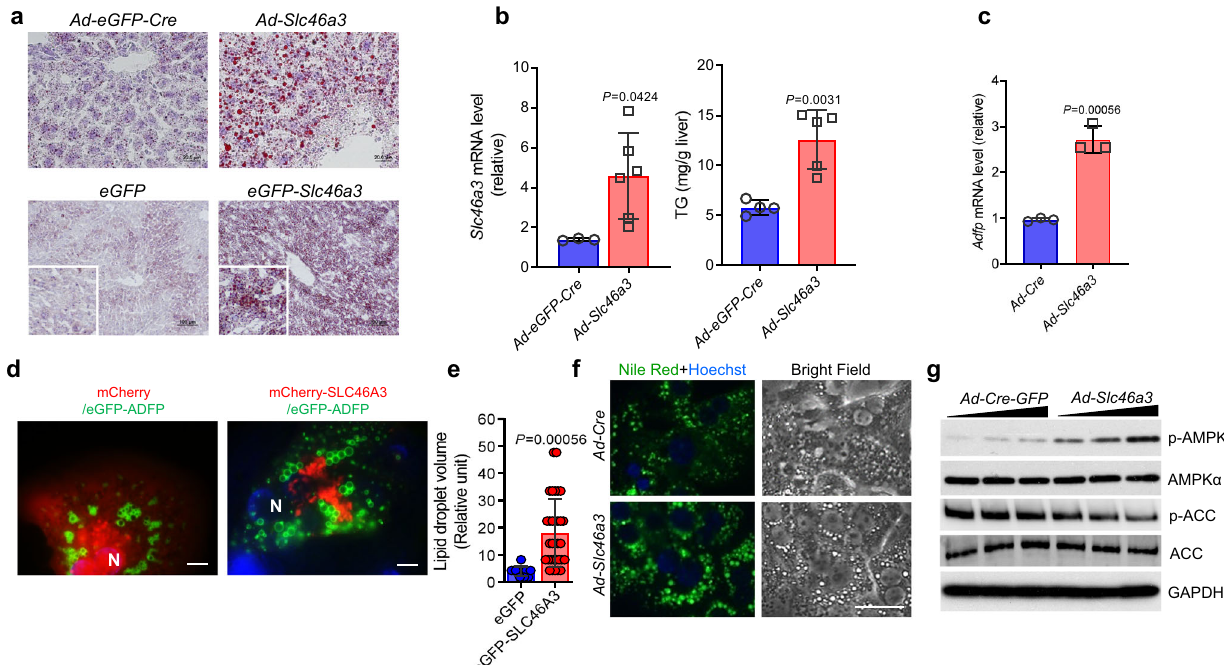
Fig. 7 SLC46A3 overexpression triggers TG accumulation in the liver. a Oil Red O staining after adenovirus-based (upper, n = 5 per group) and hydrodynamic injection-based (lower, n = 3 per group) expression of Slc46a3 mRNA in the liver. b Hepatic Slc46a3 mRNA expression (left) and TG level (right) after administration of Ad-eGFP-Cre ( n = 3 mice per group) or Ad-Slc46a3 ( n = 5 – 6 mice per group). c Hepatic Adfp mRNA expression after Ad-Slc46a3 and control Ad-Cre administration ( n = 3 per each group). d Representative fl uorescence images in the eGFP-adipophilin/mcherry-SLC46A3-expressing primary hepatocytes. The representative images were obtained from three biologically independent experiments. Scale bar, 10 μ m; N nucleus (blue color). e Relative volume of lipid droplets in the eGFP ( n = 11 counts per cell) or eGFP-SLC46A3 ( n = 32 counts per cell) expressing primary hepatocytes from ( d ). f Nile Red staining